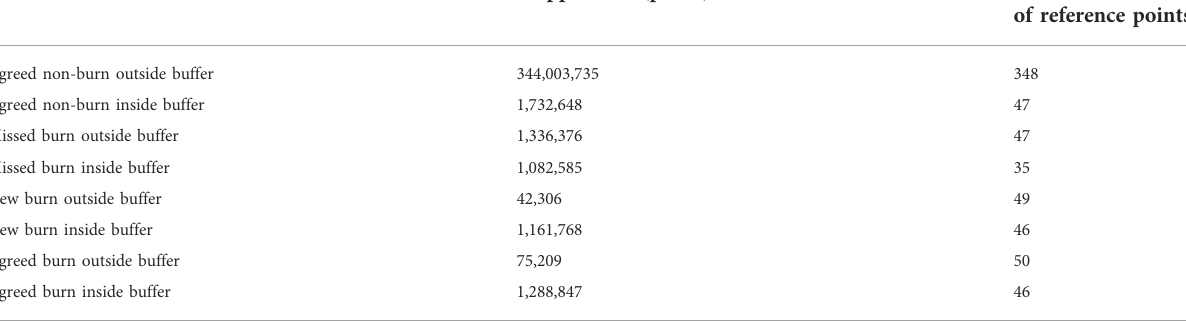
TABLE 1 Strata size and reference point